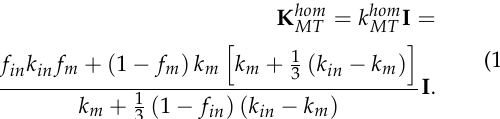
Fig. 4. Effect of volume fraction of sand on mesoscopic thermal conductivity of mortar. Table 1. Experimental determination of effect of volume fraction of PET on thermal